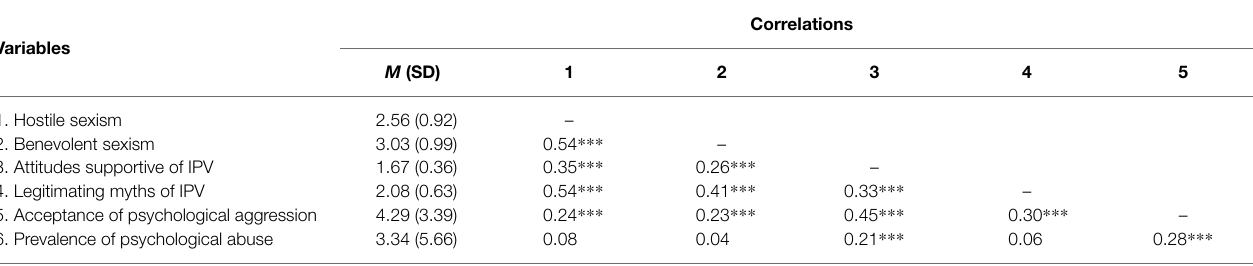
TABLE 1 | Descriptive statistics and zero-order correlations among study variables (hostile sexism, benevolent sexism, attitudes supportive of IPV, legitimating myths of IPV, acceptance of psychological aggression, prevalence of psychological abuse).